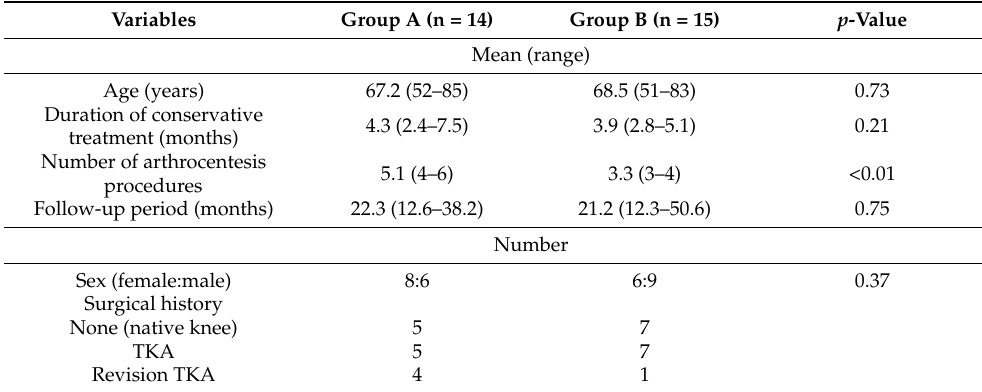
Table 1. Clinical characteristics of 16 patients who were diagnosed with knee hemarthrosis and underwent computed tomography